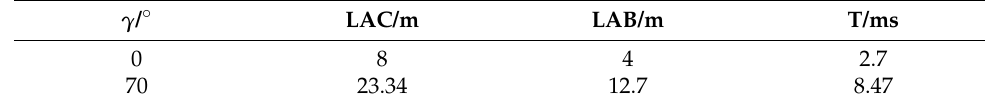
Figure 22. Schematic Diagram of The Position of The Transmitting Array in The Wake When γ = 70° . Table 3. Technical Parameters of Wake Detection.